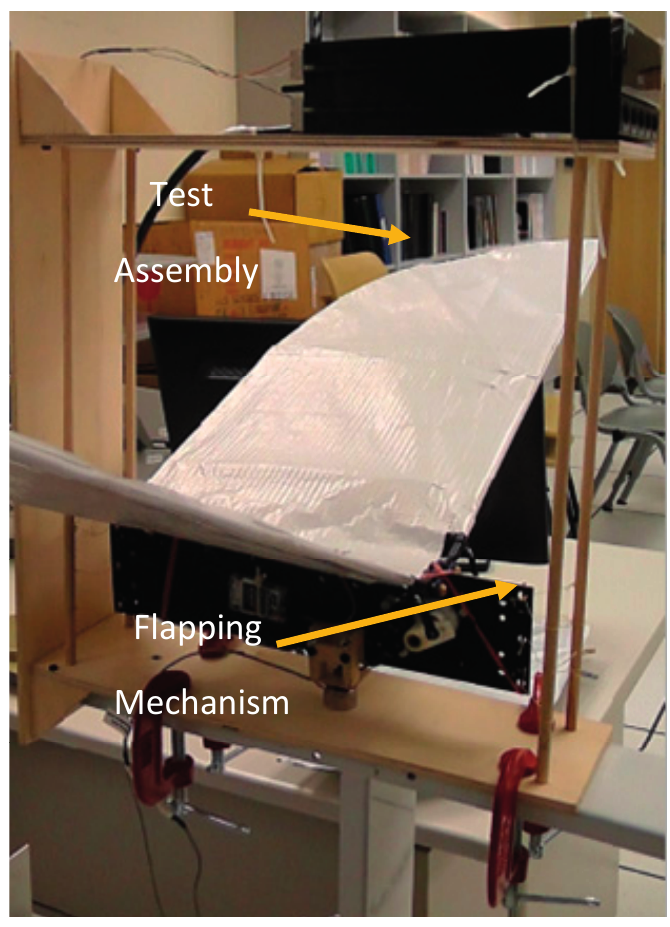
Figure 27. Test assembly and flapping